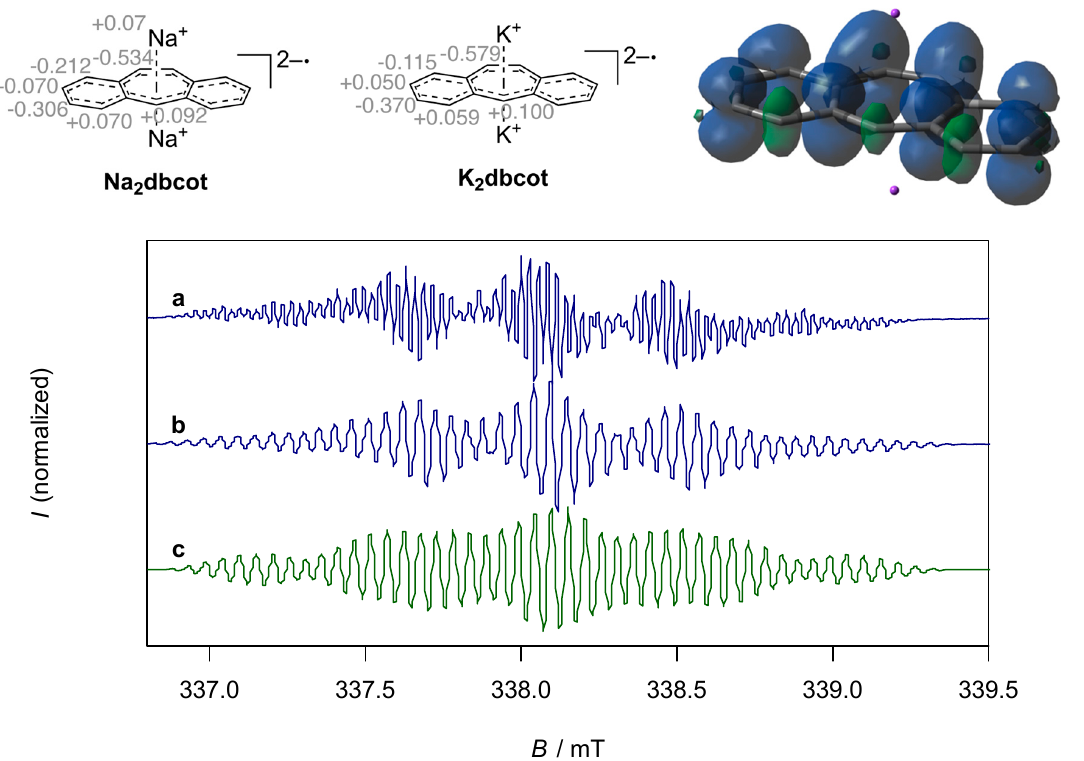
Figure 3. Top left: Reported hyperfine splittings (mT) of Na 2 trop . Top middle: Calculated hyperfine coupling constants (HFCs) (mT) from the simulated spectrum of K 2 trop . Top right: Spin density plot of K 2 trop (isovalue = 0.0009, positive spin densities in blue and negative spin densities in green). DFT calculation: PBE [38,39] 6-311+G(df, pd) [40] in a continuum solvation model (THF). Bottom ( a ): EPR spectrum of K 2 trop (0.5 mM) in THF, g = 2.0064. ( b ): EPR spectrum of K 2 trop (0.5 mM)